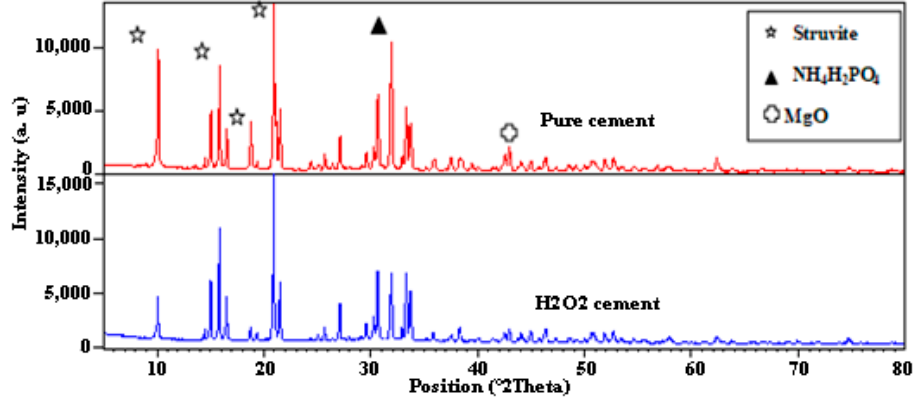
Figure 1. X-ray diffraction pattern of pure and H 2 O 2